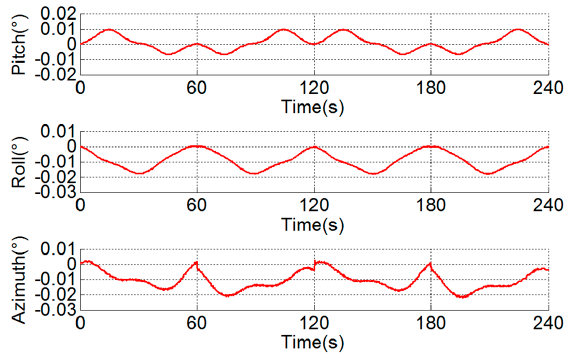
Figure 4. RINS and associated experimental equipment.